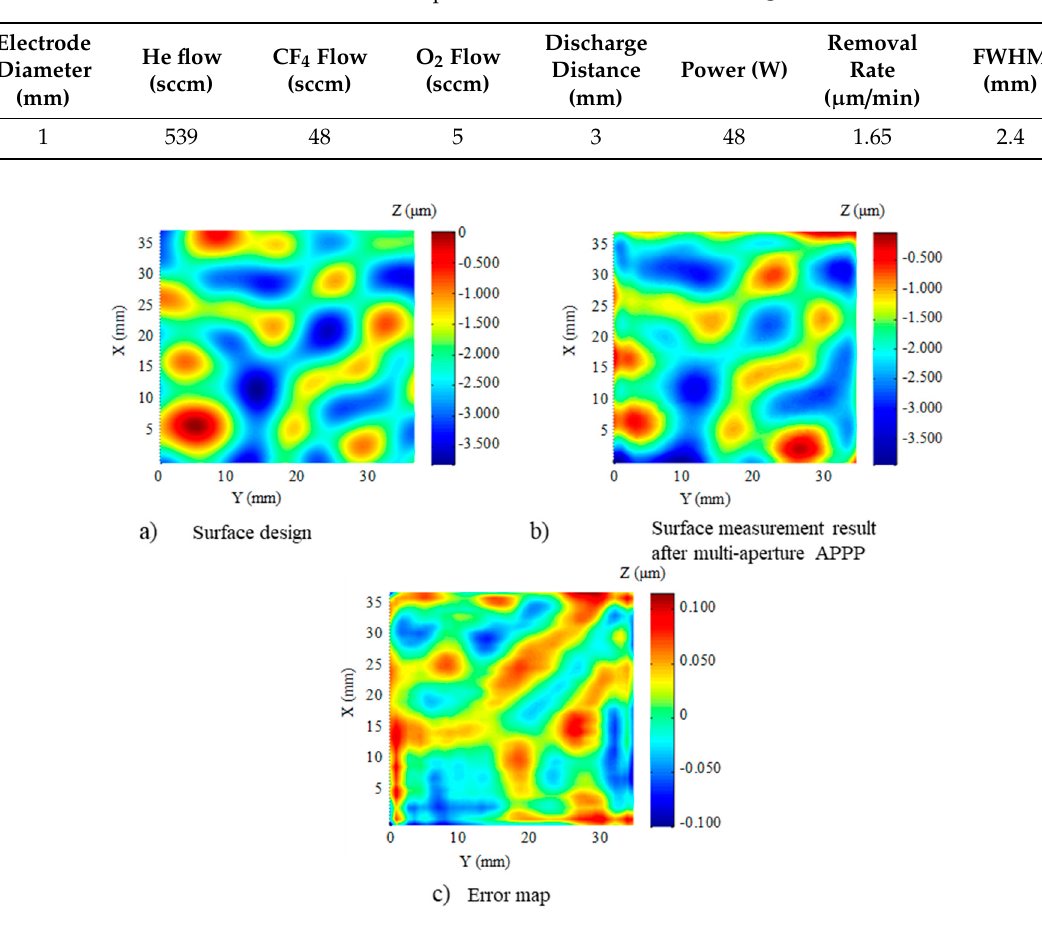
Figure 8. Multi-aperture APPP results of CPP.